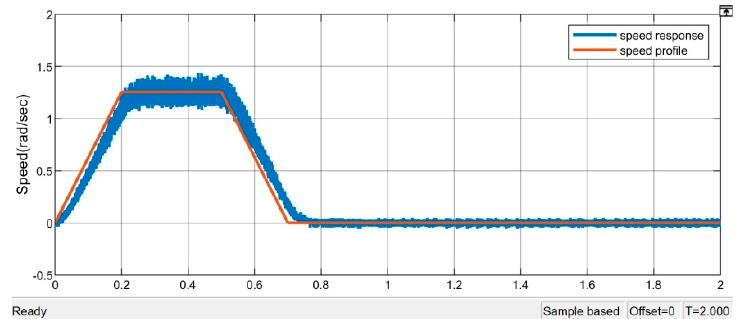
Figure 7. The speed response without load and speed command profile.